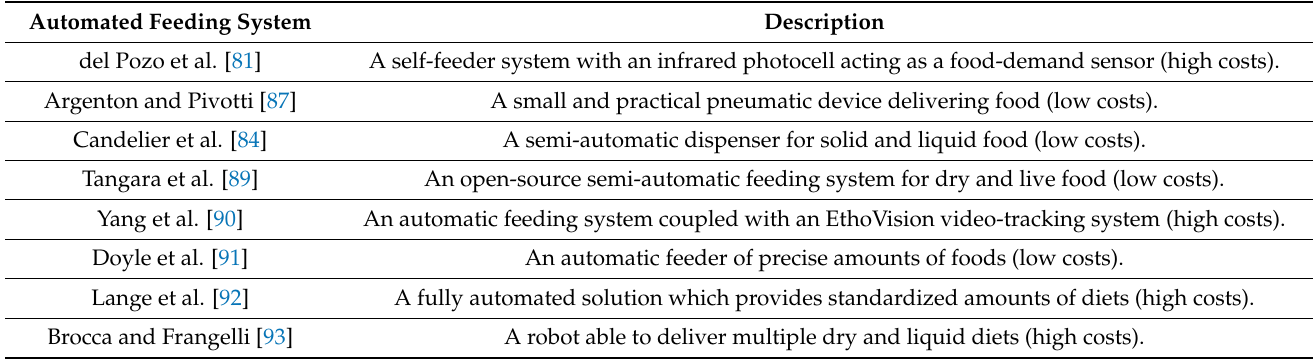
Table 3. Summary of automated feeding systems for